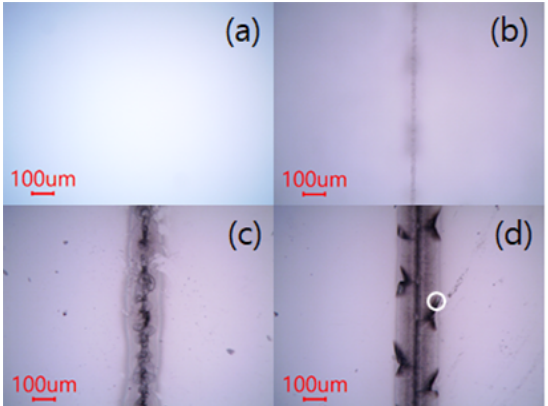
Figure 3. Result of damage threshold test for the soda-lime glass substrate. Laser power: ( a ) 0.33 W, ( b ) 0.72 W, ( c ) 1.22 W, and ( d ) 1.76 W. The circle in the figure denotes a crack.